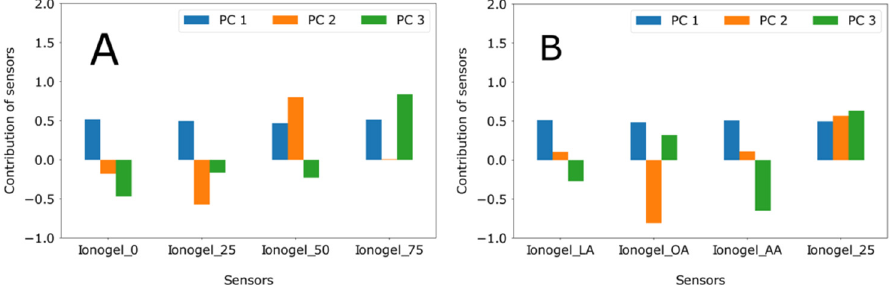
Figure 8. Loading plot showing the contribution of each sensor in the both sets for the principal components, ( A ) with set A and ( B ) with set B.